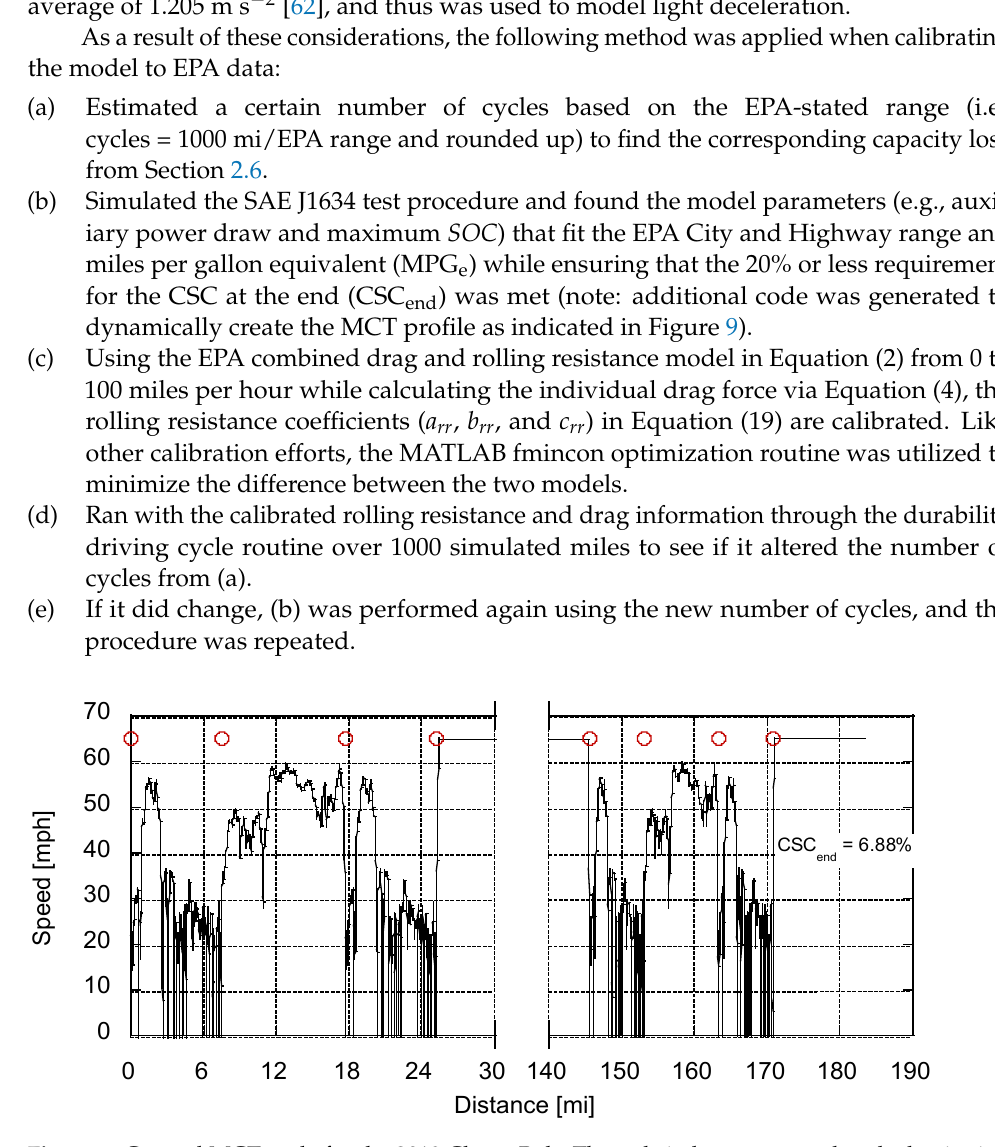
Figure 9. Created MCT cycle for the 2019 Chevy Bolt. The red circles correspond to the beginning and ending of the different components of the cycle (UDDS, HWFET, and CSC). and ending of the different components of the cycle (UDDS, HWFET, and At this point, the model was fully calibrated to the SAE J1634 test procedure.